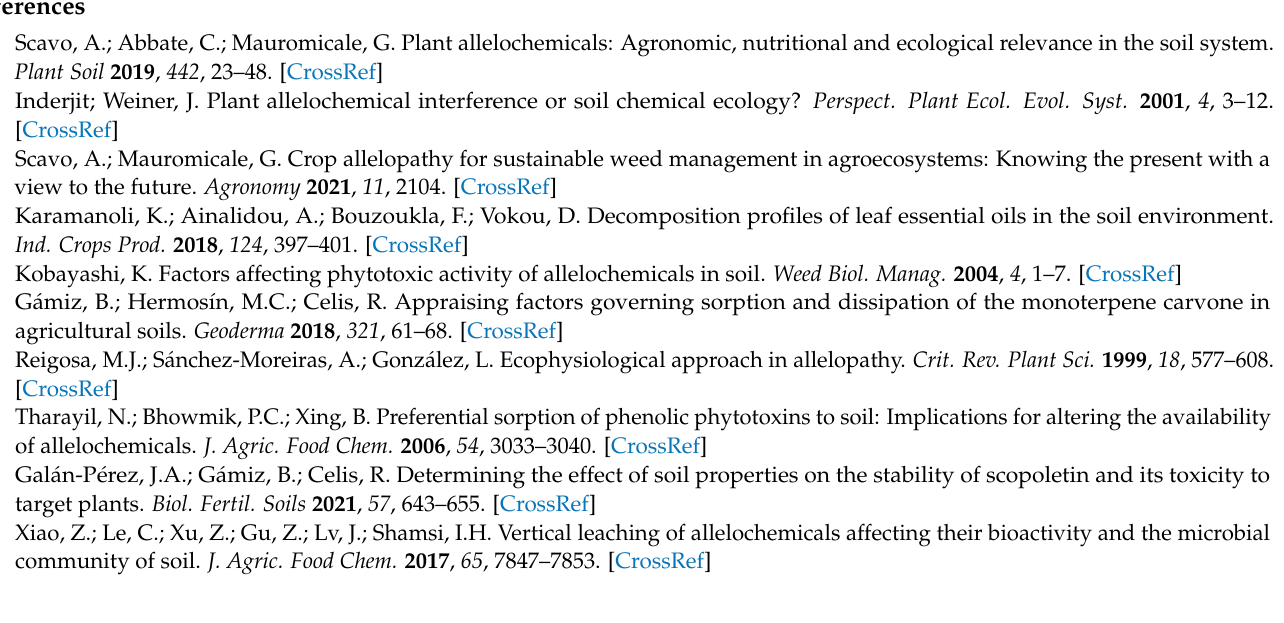
Figure S3: Distribution coefficients for rac-pulegone on different organoclays; Figure S4: Schematic representation of the oleate-modified hydrotalcite sample (OHT); Figure S5: Chromatogram of a standard solution of